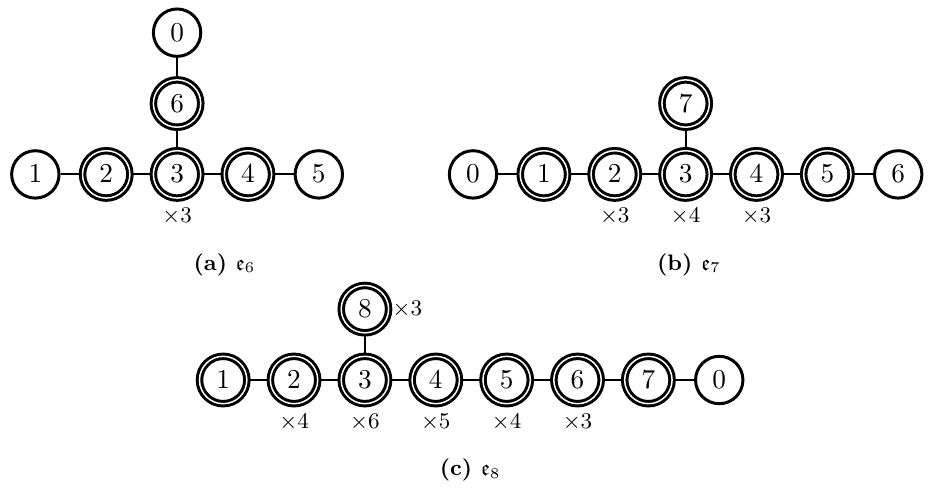
Figure 4. Dynkin diagrams for e 6 , e 7 and e 8 . The numbers within each circle give the value of I corresponding to each node, with the affine node having I = 0 . Nodes marked with two concentric circles occur with multiplicity greater than 1 in the fiber. If the multiplicity is greater than 2, the multiplicity is indicated just outside the node. Nodes with concentric circles without a given multiplicity have multiplicity